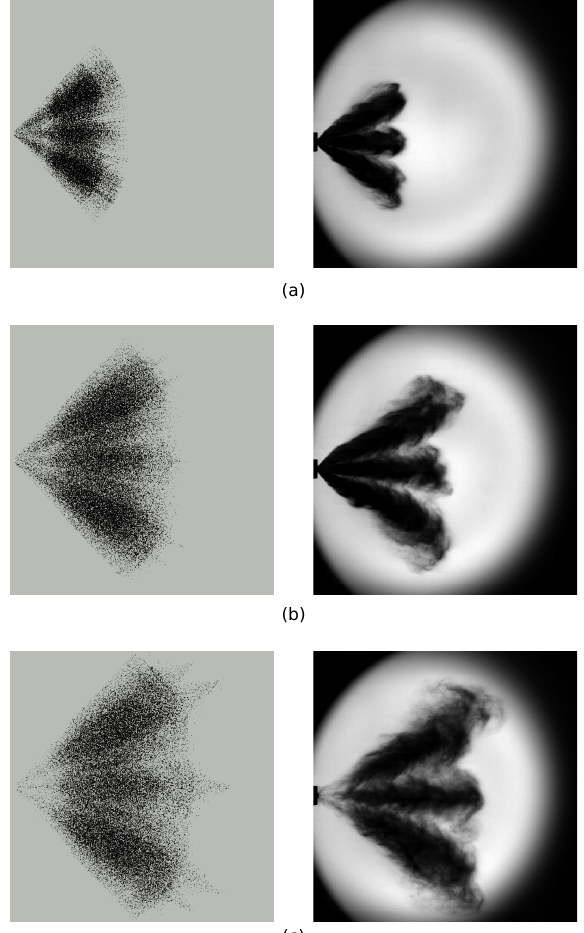
Figure 13. Numerical ( left ) vs. CMT experimental ( right ) liquid morphology images for the G2 cold condition for n–heptane. ( a ) at 0.3ms, ( b ) at 0.6ms and ( c ) at 0.9ms after SOI.